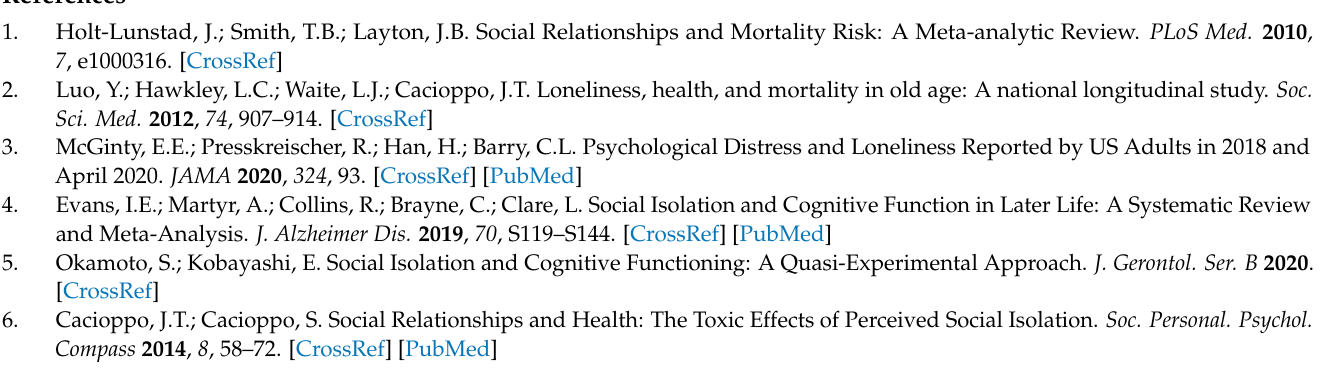
Supplementary Materials: The table of articles included in the review are available online at